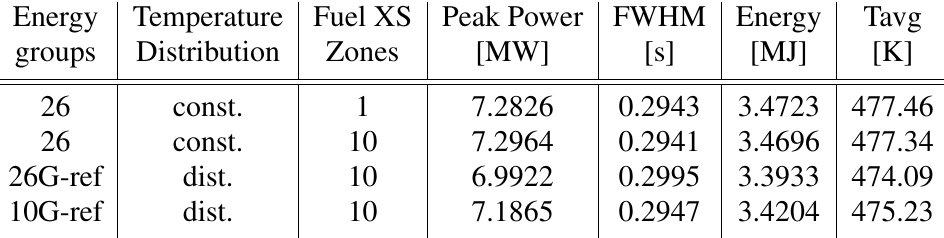
Table 4: 1-D heterogeneous results with 26 and 10 neutron energy groups